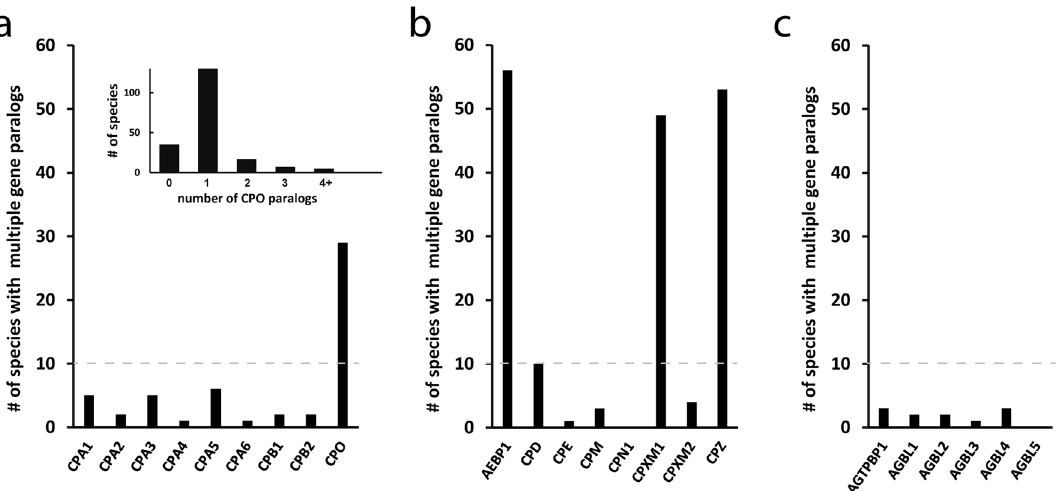
Figure 2. Several genes within the M14 family are further duplicated within many species. All orthologs of human M14 metallocarboxypeptidases of the ( a ) A/B subfamily, ( b ) N/E subfamily, and ( c ) CCP subfamily were identified in Ensembl Release 98. These were manually validated using information on gene synteny and completeness and updated with information from Ensembl Release